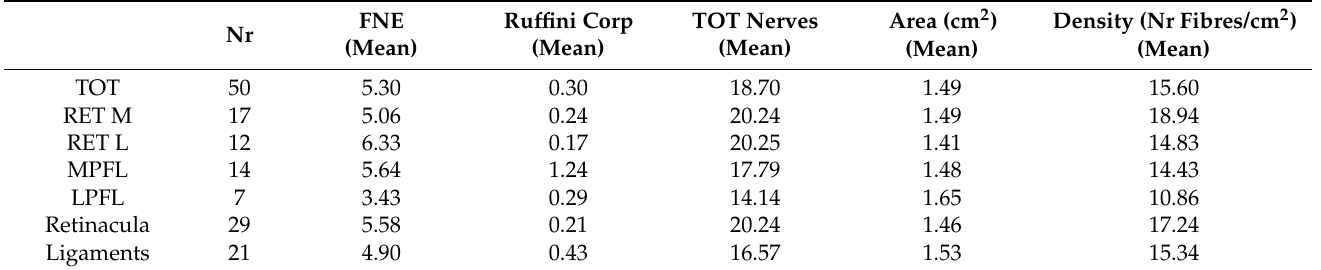
Table 2. Density and number of nerve fibres in ligaments and